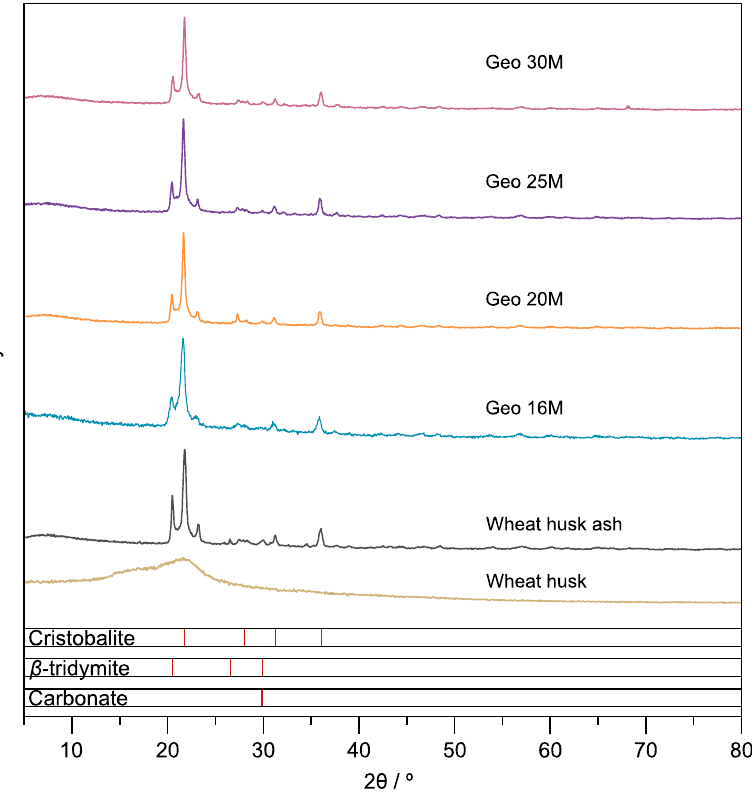
Figure 4. Di ff ractograms of WH, WHA, Geo 16M, Geo 20M, Geo 25M, and Geo 30M. Figure 4. Diffractograms of WH, WHA, Geo 16M, Geo 20M, Geo 25M, and Geo 30M. Table 3. BET characterization of Geo 16M and Geo